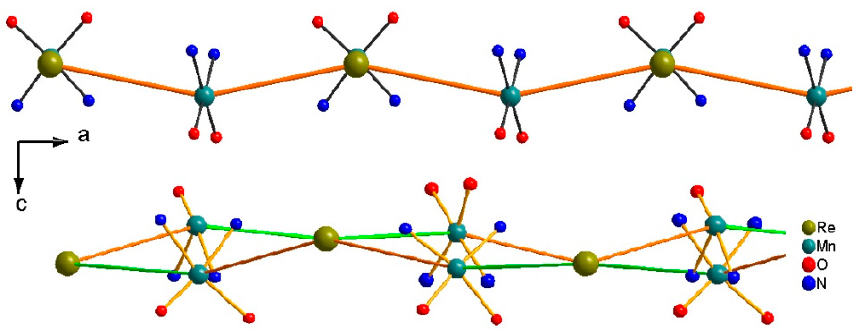
Figure 21. Schematic presentation of the anionic layer of 15 ( top ) and 14 ( bottom ), with projection along the b axis. The Re-CN apical —{MnN 2 O 2 } and Re-CN equatorial —{MnN 2 O 2 } connections are colored in green and orange, respectively [56].